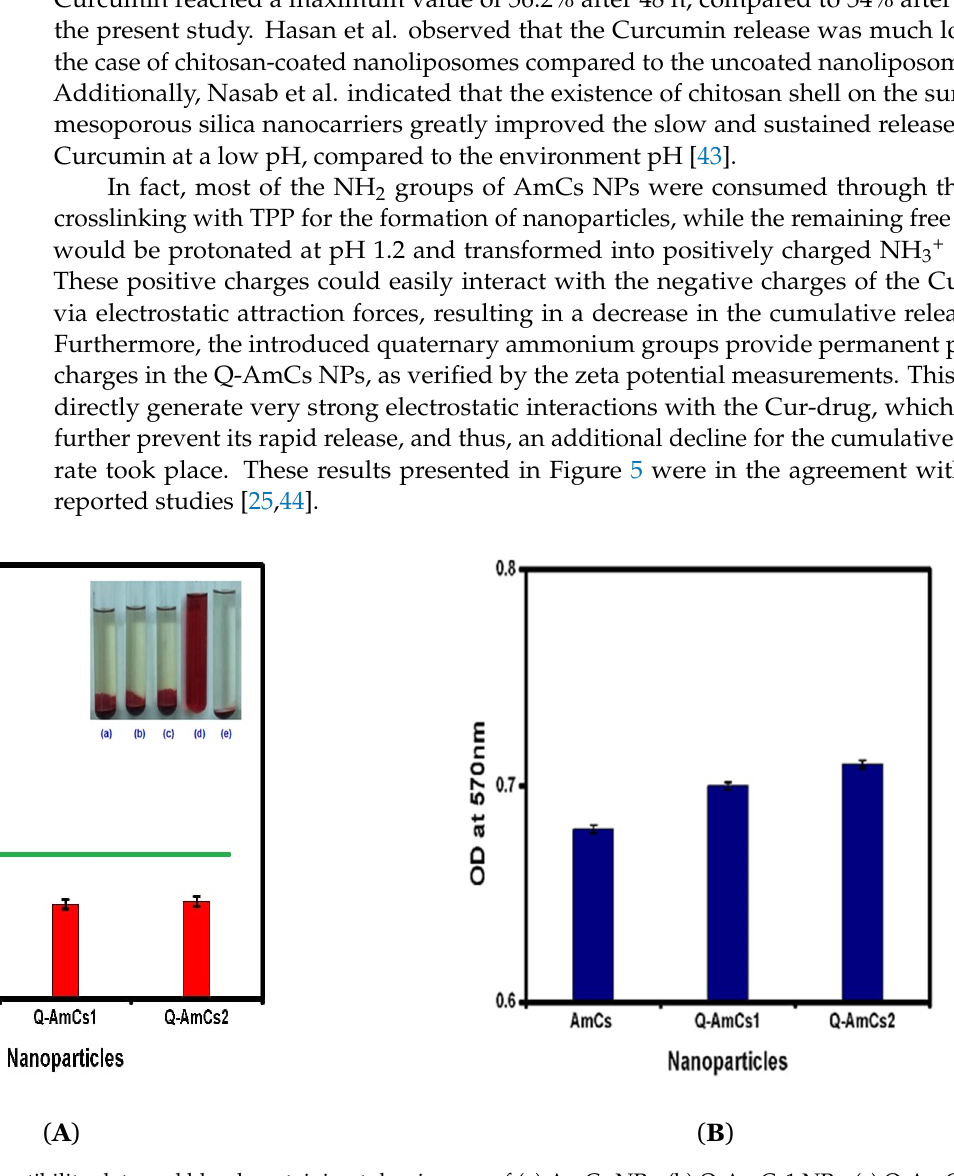
Figure 6. ( A ) Hemocomptibility data and blood-containing tubes images of (a) AmCs NPs, (b) Q-AmCs1 NPs, (c) Q-AmCs2 NPs, (d) positive control, and (e) negative control) nanoparticles. ( B ) Biodegradation profiles of AmCs, Q-AmCs1, and Q- AmCs2 NPs shown by the formation of DNS adduct with liberated sugars, after incubation of NPs (10 mg) with lysozyme for 3 days, at 37 °C. All measurements were performed in triplicates ( n = 3), and the values were expressed as mean + standard deviation (±SD).